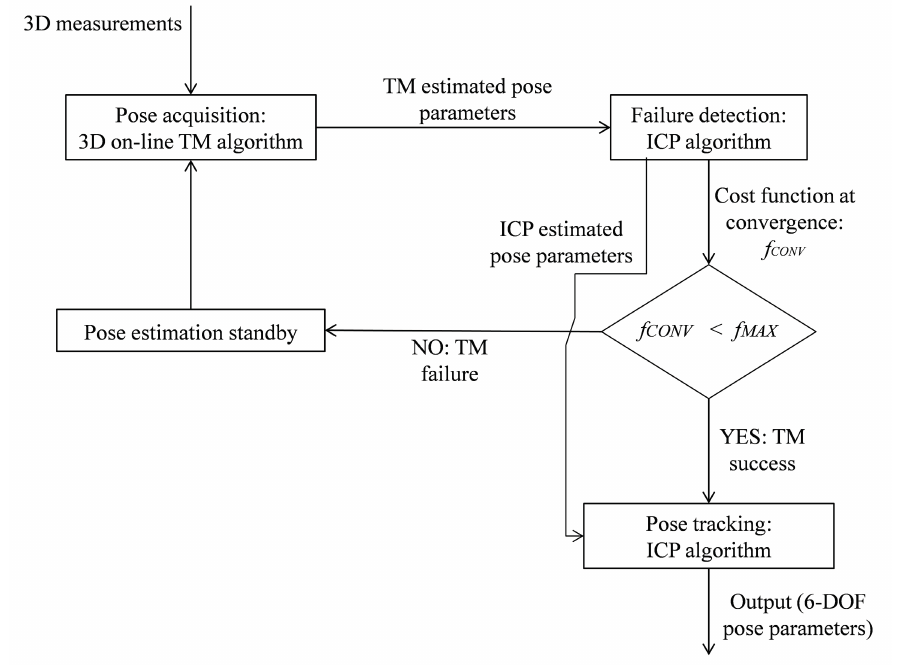
Figure 10. Logic for autonomous verification of successful pose estimation for the proposed TM